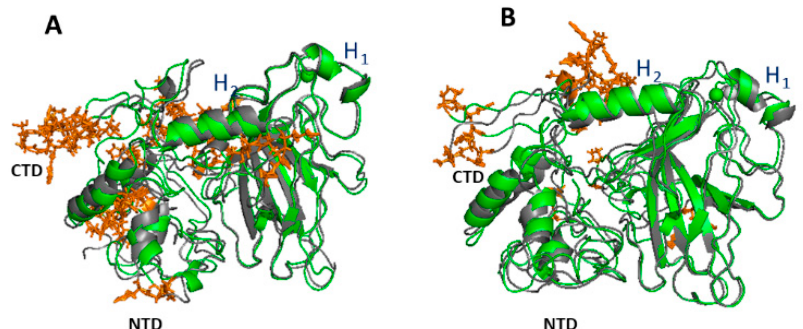
Figure 4. Extreme trajectory conformations projected along: ( A ) the first and ( B ) the second eigenvector for p53wt. The Zn ion is represented as a sphere. Regions characterized by displacements between the two extreme projections higher than 0.6 nm are marked by orange sticks.